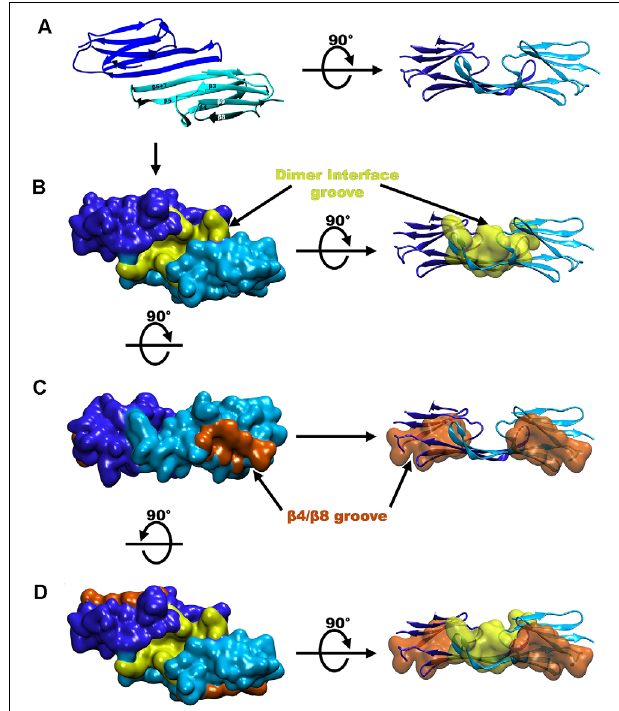
FIGURE 3 | Groove locations in the crystal structure of Hsp27. (A) A ribbon diagram of the Hsp27 dimer (PDB 4MJH). (B) Hsp27 structure seen in panel (A) but in surface representation where the dimer interface groove is shaded yellow. (C) Hsp27 β 4/ β 8 groove (colored in orange). (D) Representation of the three grooves on a dimeric unit colored the same as in panels (B,C)